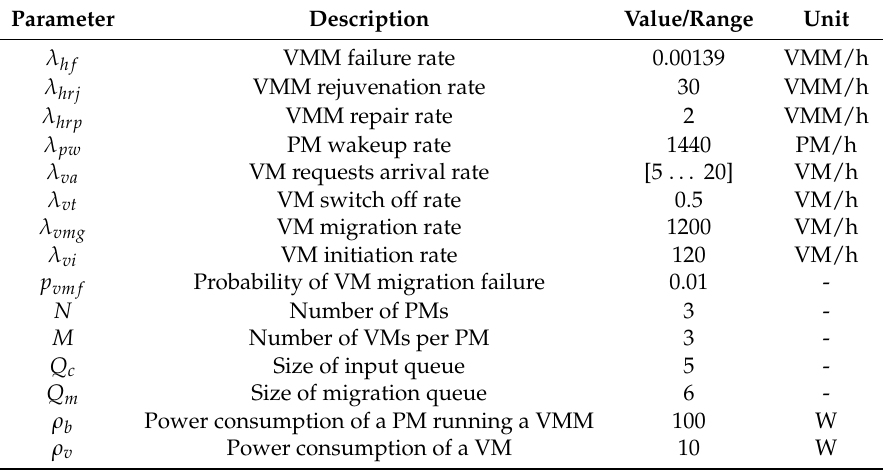
Table 4. Configuration of the cloud system under